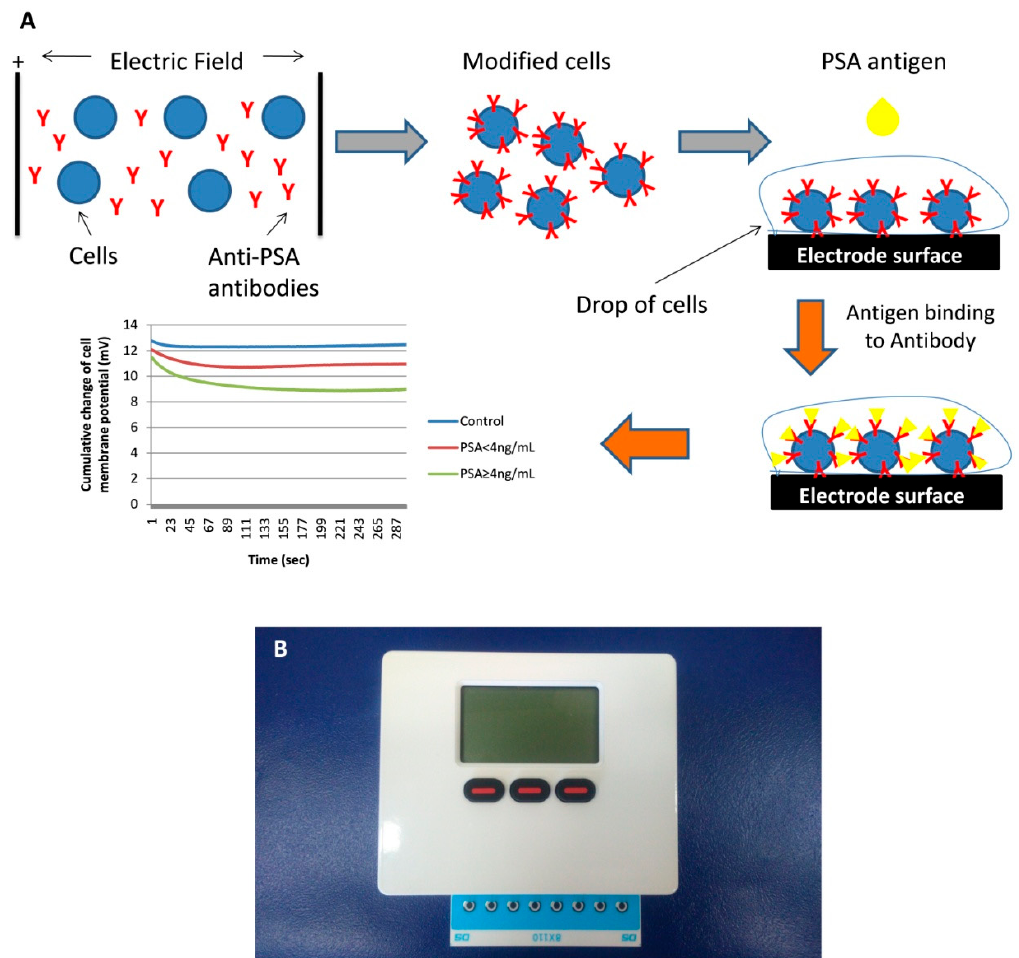
Figure 1. ( A ) Schematic picture of the assay workflow ( B ) Portable biosensor read-out device with a disposable eight-position screen-printed electrode